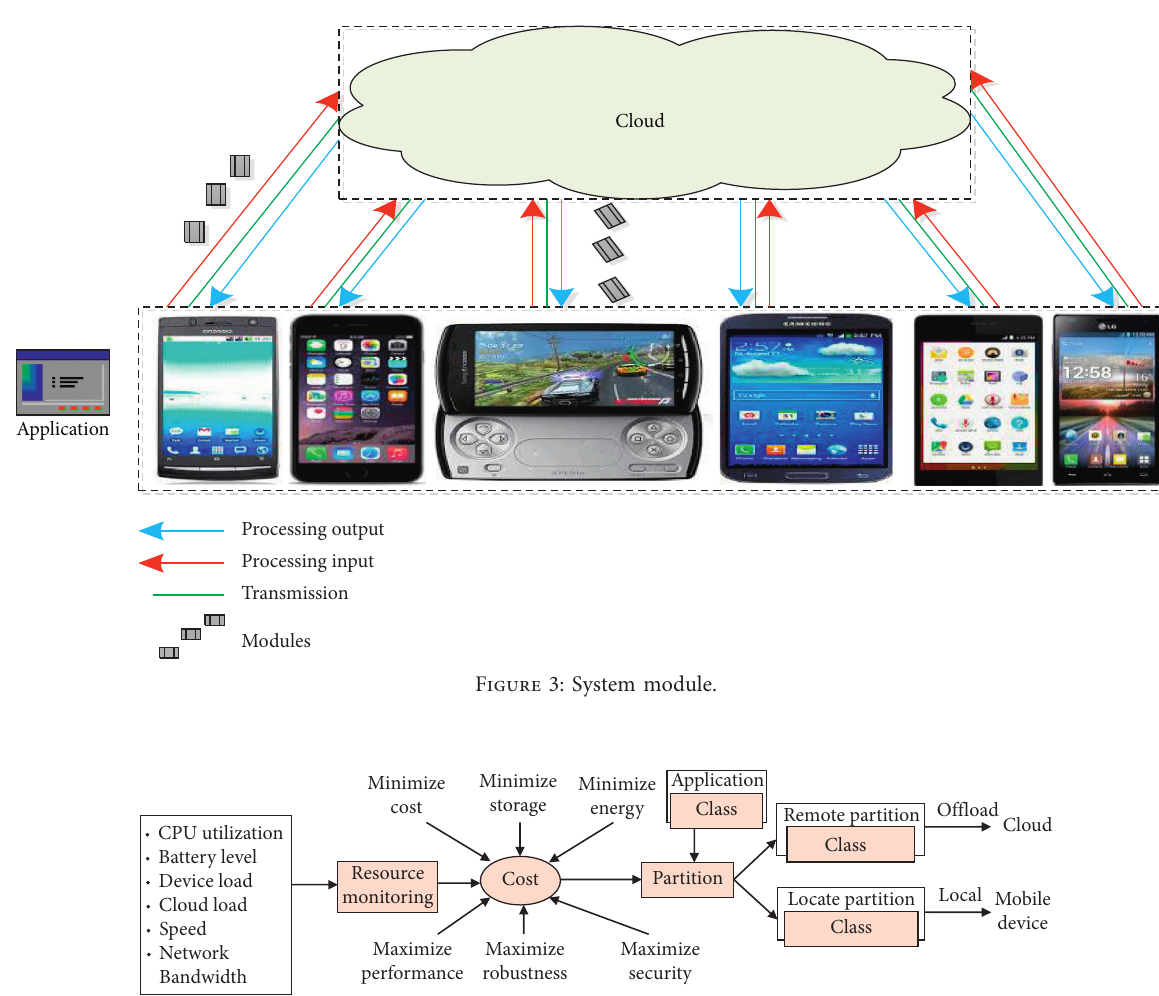
Figure 4: Cloud offloading systems architecture